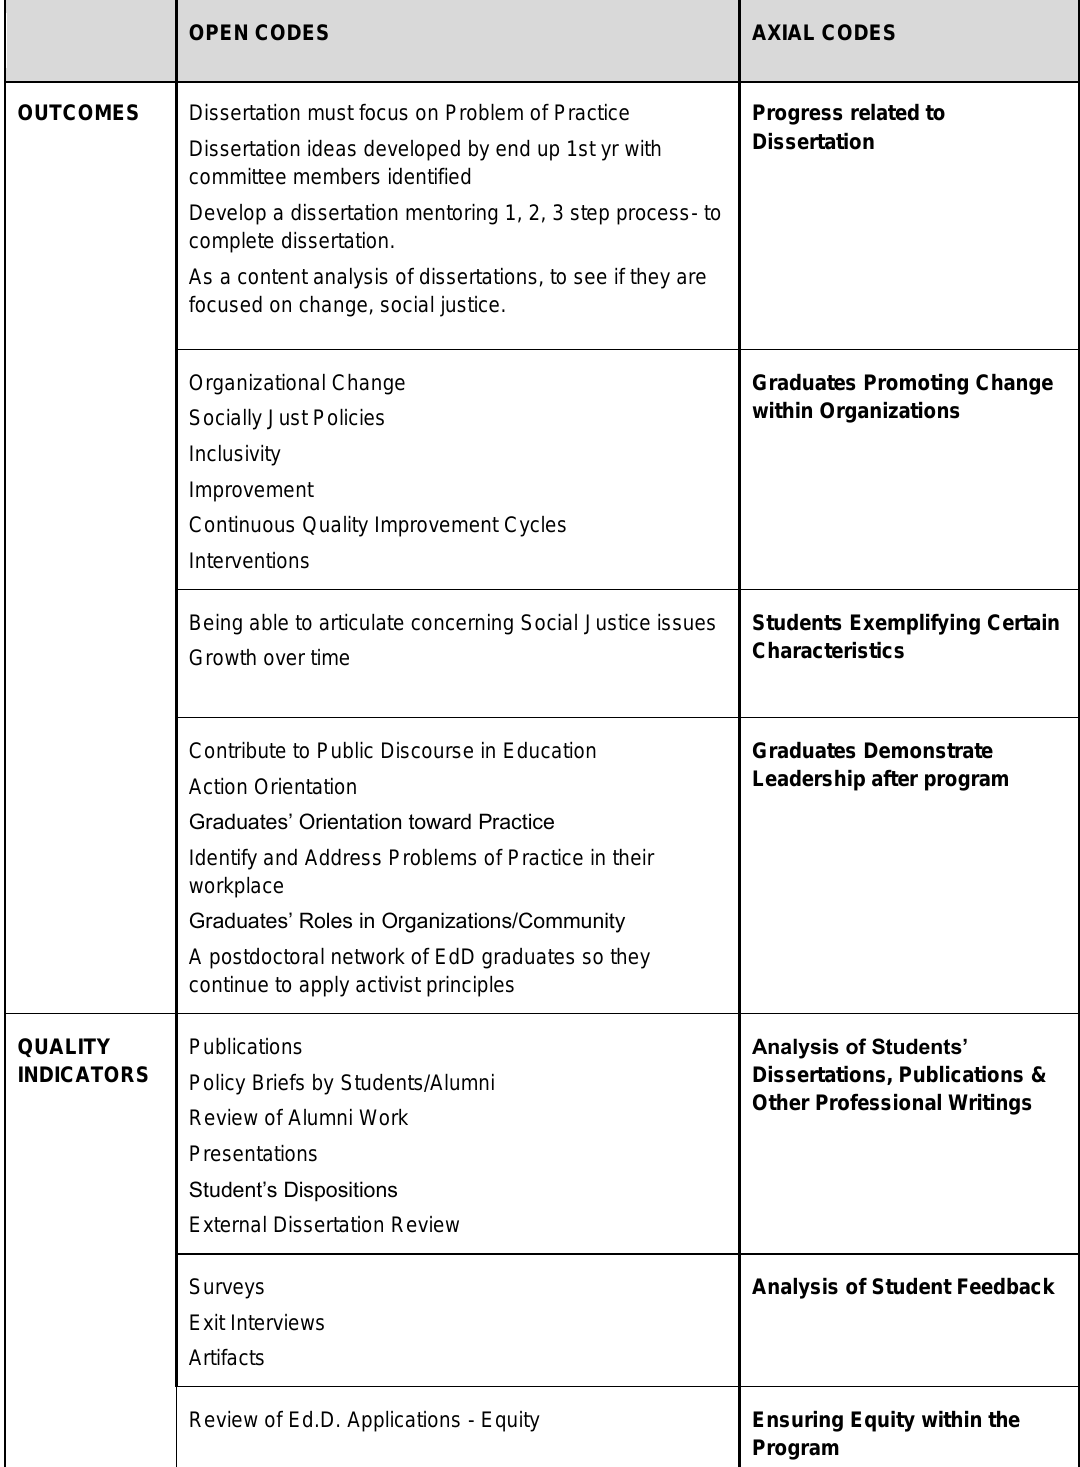
Table 4. Outcomes and Quality Indicators to Measure Progress Toward the Developing